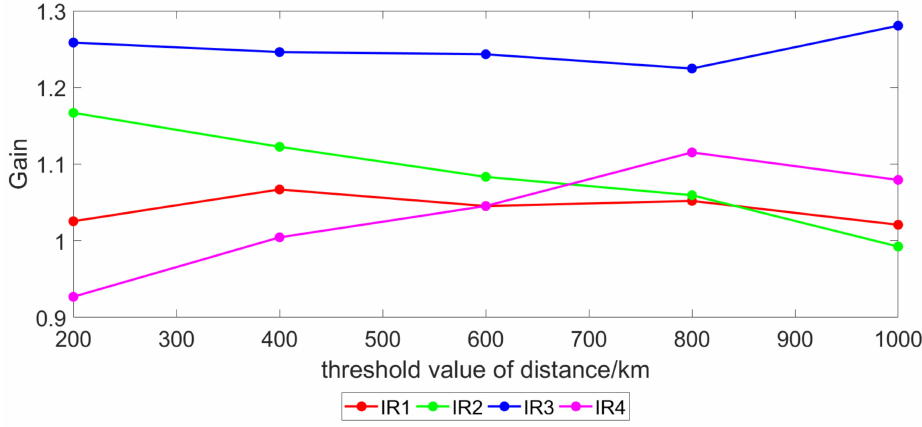
Figure 8. Probability gains in different channels at different distance